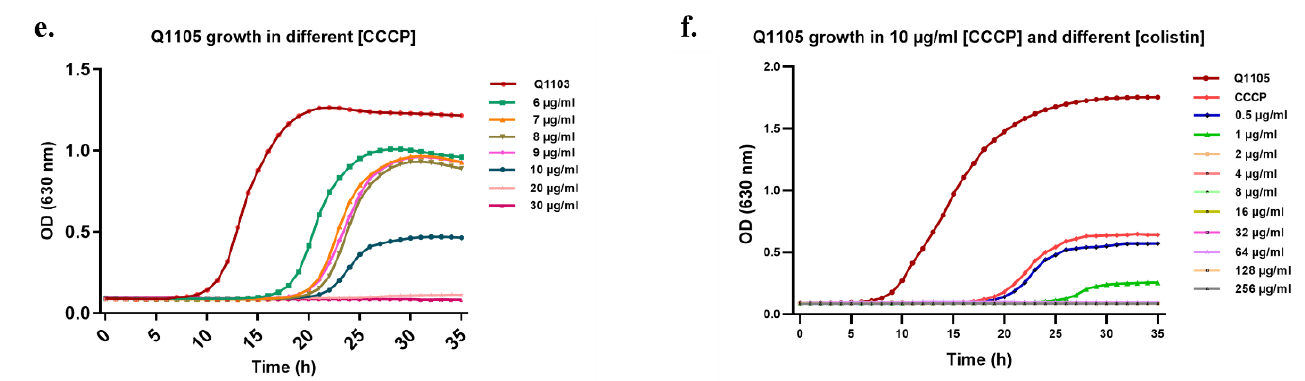
Figure 4. Growth curves of studied strains in different conditions. ( a ) Shows the growth of E. coli in different CO concentrations, ( c ) and ( e ) show the growth of Brucella strains Q1103 and Q1105 in different CCCP concentrations ( b ) and ( d , f ) show the growth of the three strains in different CO concentrations with CCCP (10 µ g/mL). Each graph represents the mean of three independent experiments ( p < 0.0001). CCCP: carbonyl cyanide 3-chloro phenyl hydrazone.